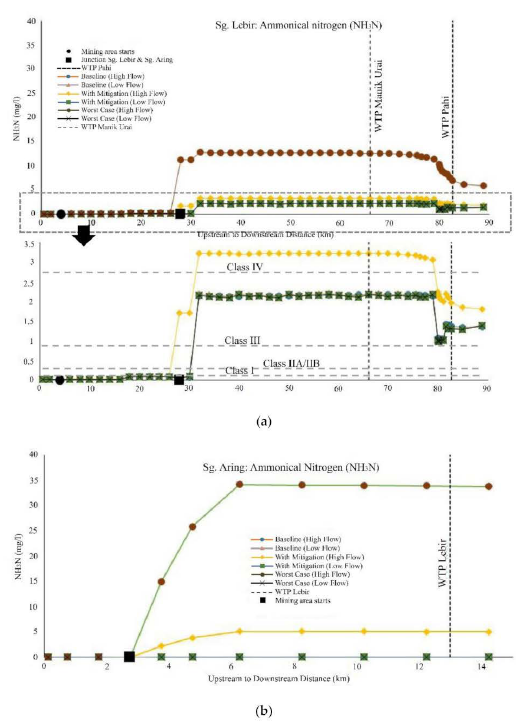
Figure 6. ( a , b ) showing NH 3 N concentrations in different scenarios for Sungai Lebir and Sungai Aring,